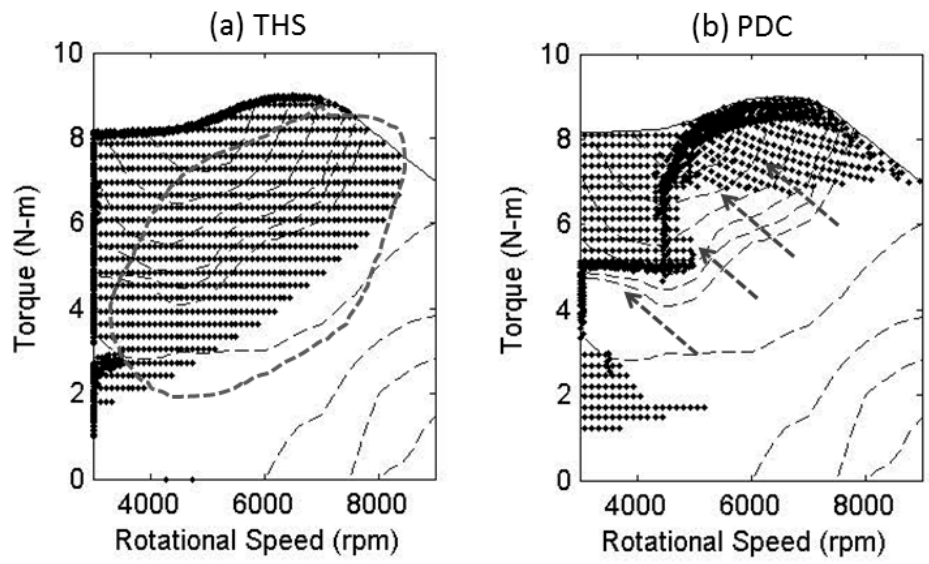
Figure 12. Distributions of the optimal operating points of E for: ( a ) THS; and ( b ) PDC.